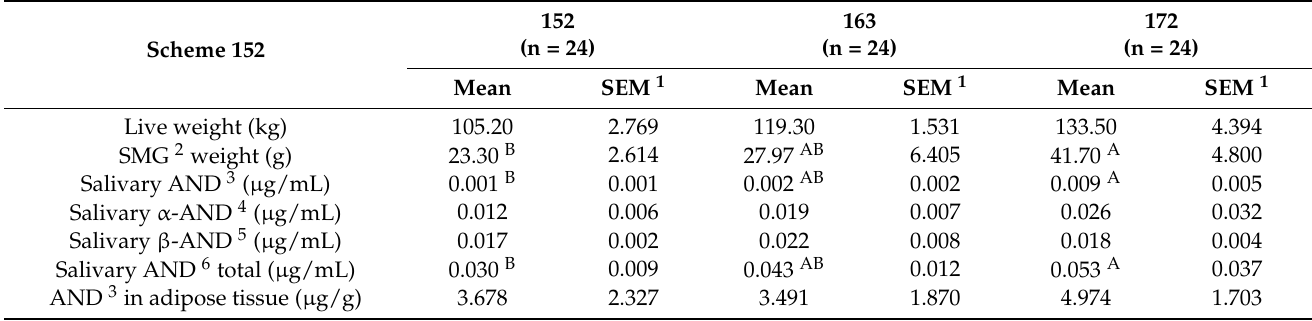
Table 1. Comparison of groups of boars as of slaughter date for levels of AND, α -AND, and β -AND.